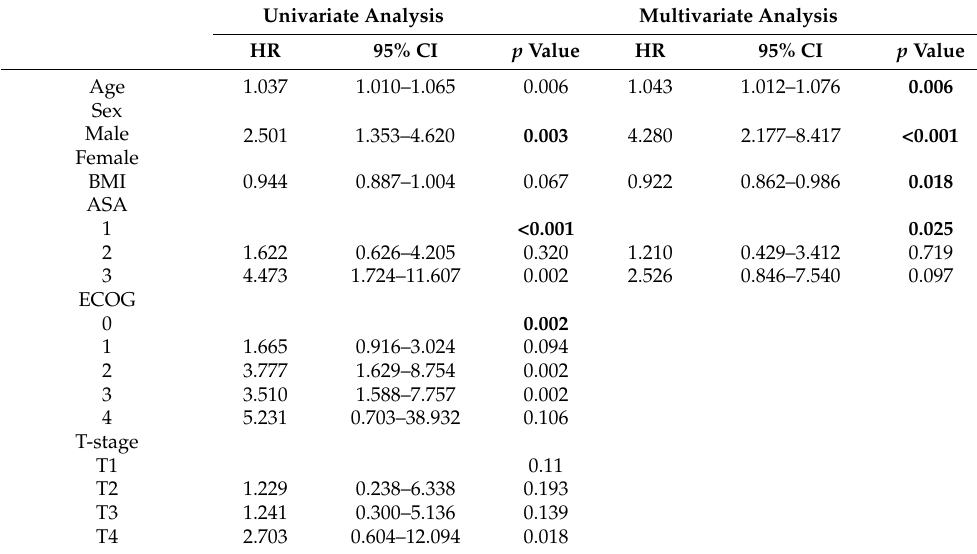
Table 6. Multivariate analysis of clinicopathological variables for OS in patients with CC in the discovery cohort. (ECOG PS: Eastern Cooperative Oncology Group performance